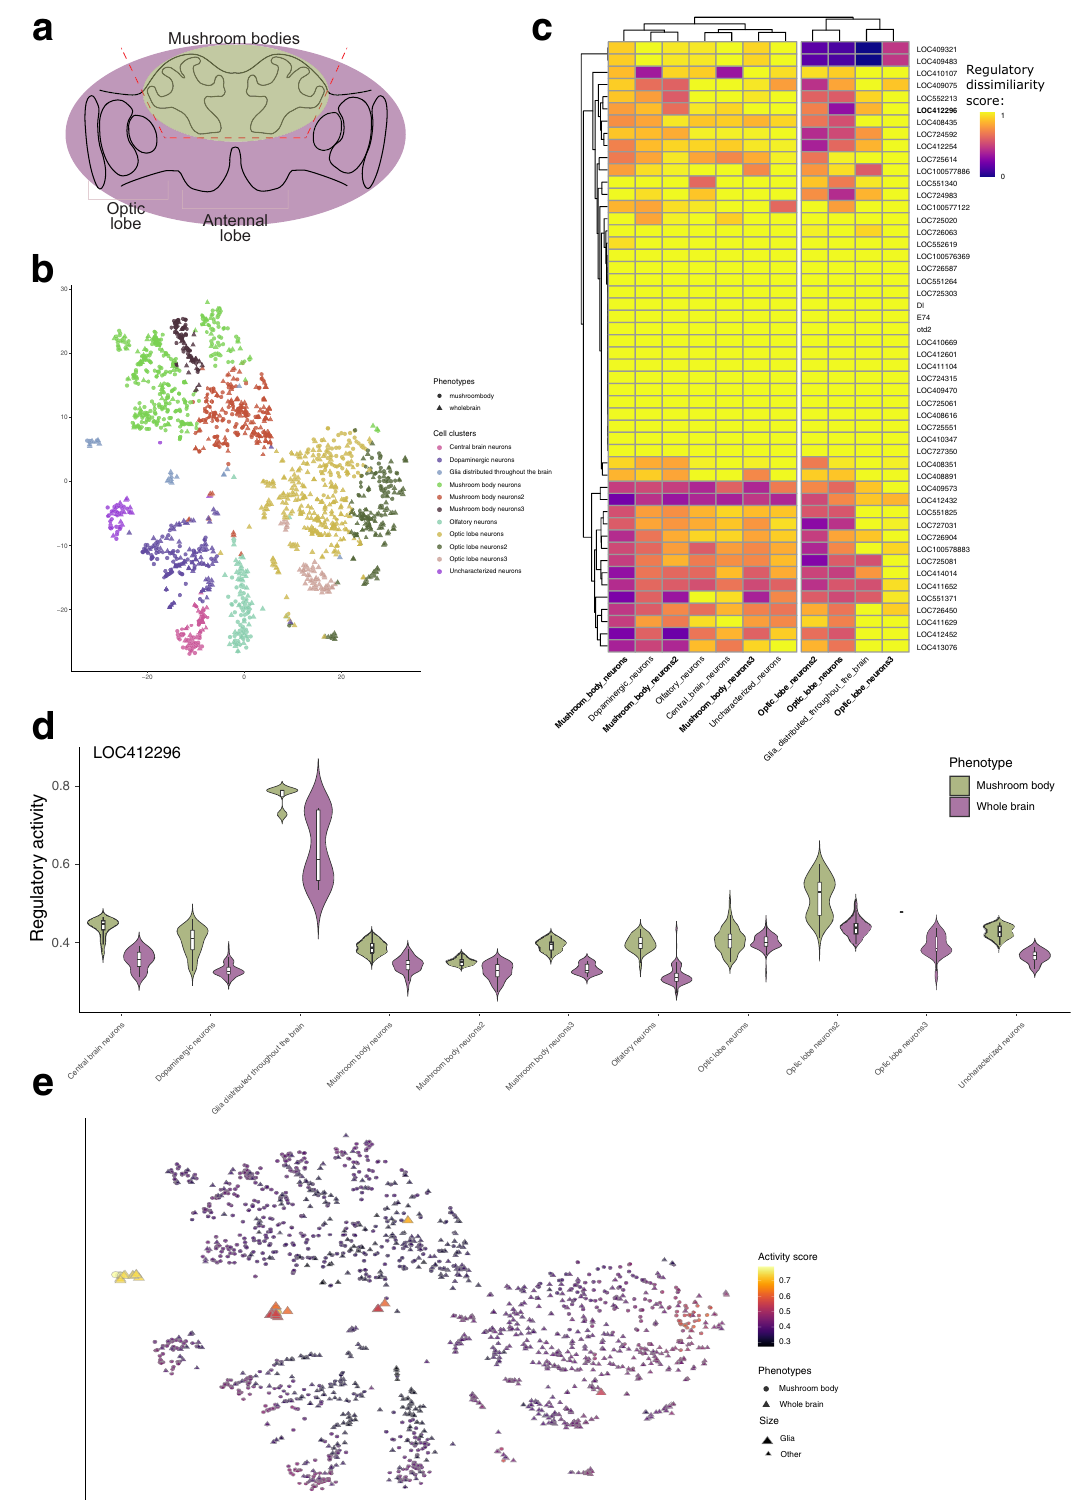
Fig. 7 Additional results of SimiC on the bee brain dataset containing cells coming from either whole-brain (WB) or mushroom body (MB) 70 . a Scheme depicting the base anatomy of the bee brain, and the line (dashed red) marking the surgical separation of the MB. b tSNE visualization of the cells colored by cell state and shaped by the phenotype. c Heatmap depicting the regulatory dissimilarity score across the whole brain and the mushroom body, for each cell state. d Violin plots showing the regulatory activity of the regulon LOC412296 on the different cell states, on the mushroom body, and whole brain. e tSNE visualization of the bee brain cells colored by the regulatory activity score of the regulon LOC412296. Shapes correspond to the two studied phenotypes and the size highligths the cells belonging to the